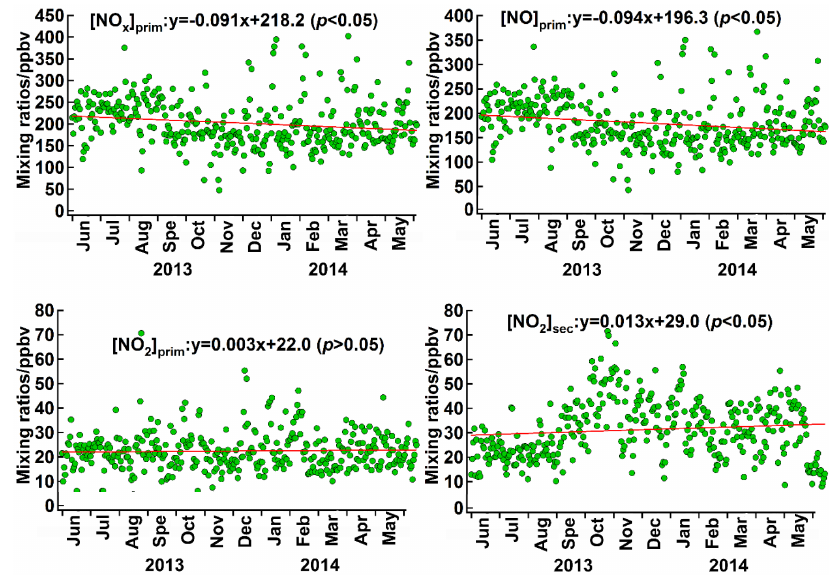
Figure 5. Variation trends of the daily average primary NO x , NO and NO 2 and secondary NO 2 at MK from June 2013 to May 2014. In the equation label x has a unit of days. Table 5. Changing rates of primary NO x , NO, NO 2 and secondary NO 2 (ppbvday − 1